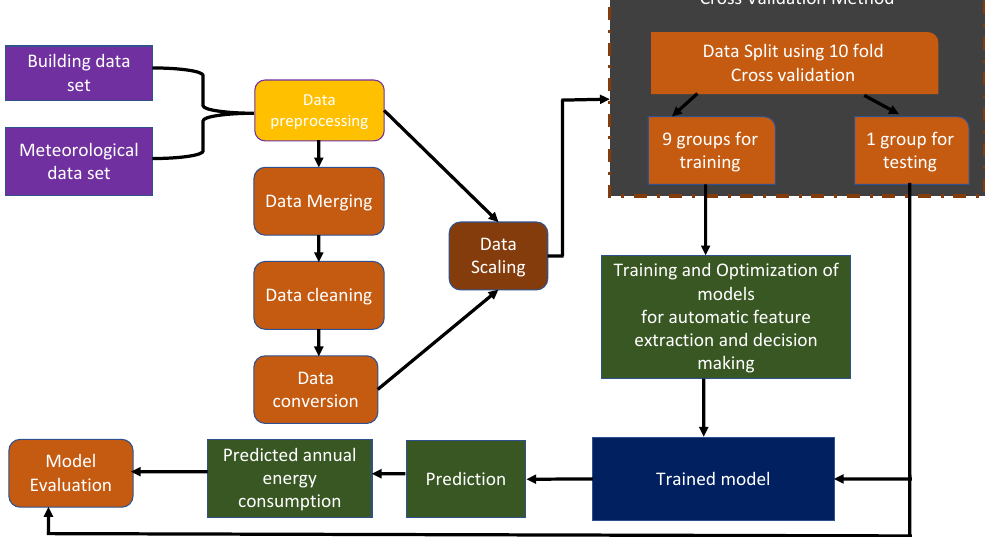
Figure 5. The flowchart of the proposed framework for annual energy